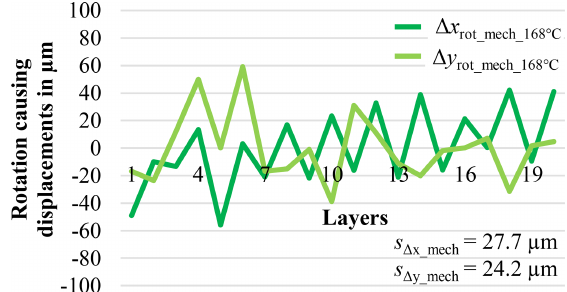
Figure 17. Rotation causing displacements of rotatory components (cid:49)x rot and (cid:49)y rot of the reference pipes at process temperature ( ∼ 168 ◦ C) with the mechanical influence of powder application in the x